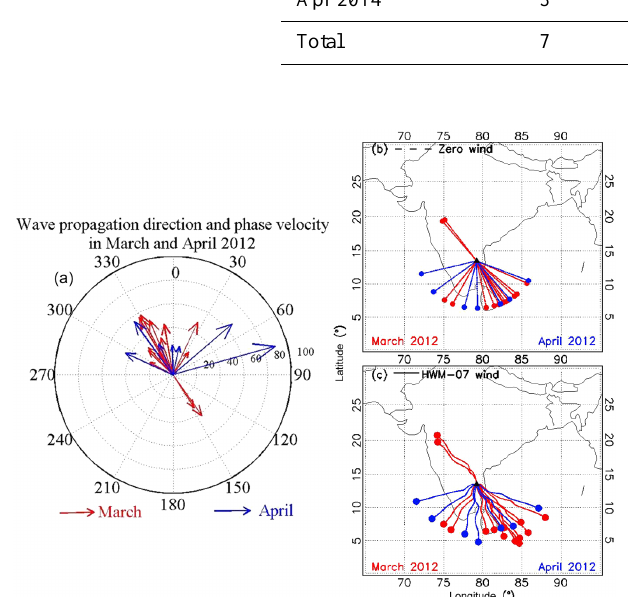
Figure 6. As in Fig. 5 but for the year 2012.